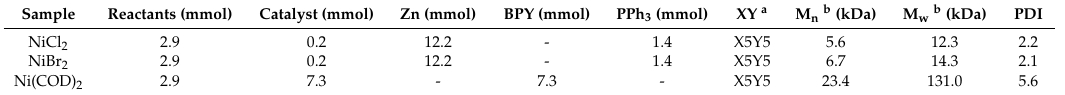
Table 3. Product 3 syntheses and molecular weights.